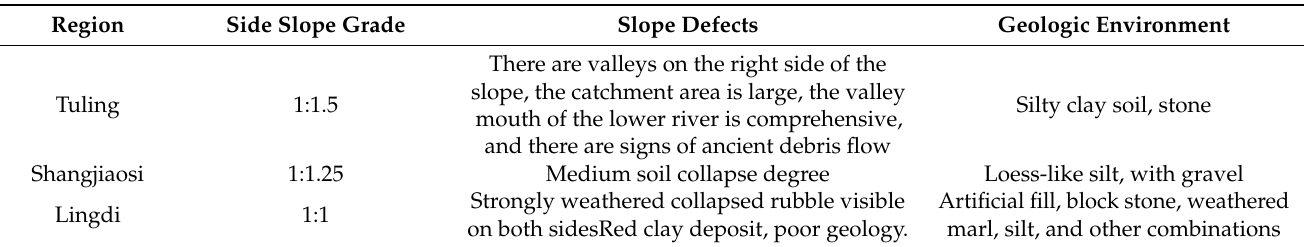
Table 1. Geological survey of highway